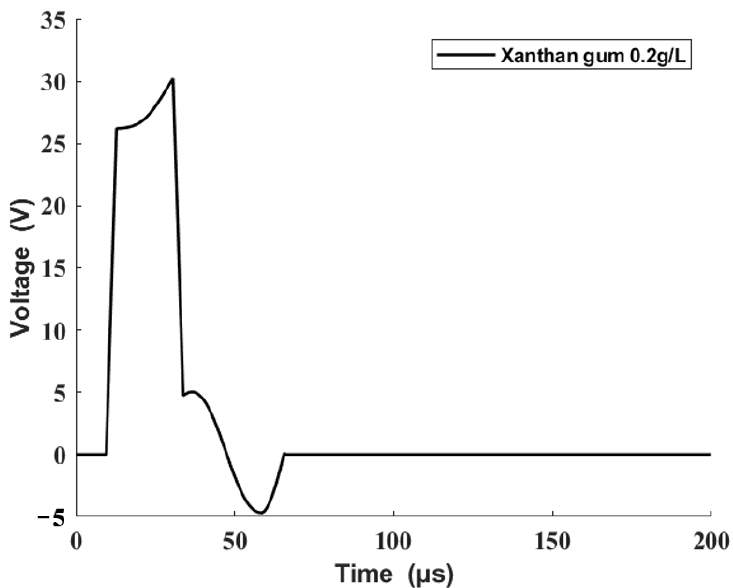
Figure 12. Modified driving waveform.